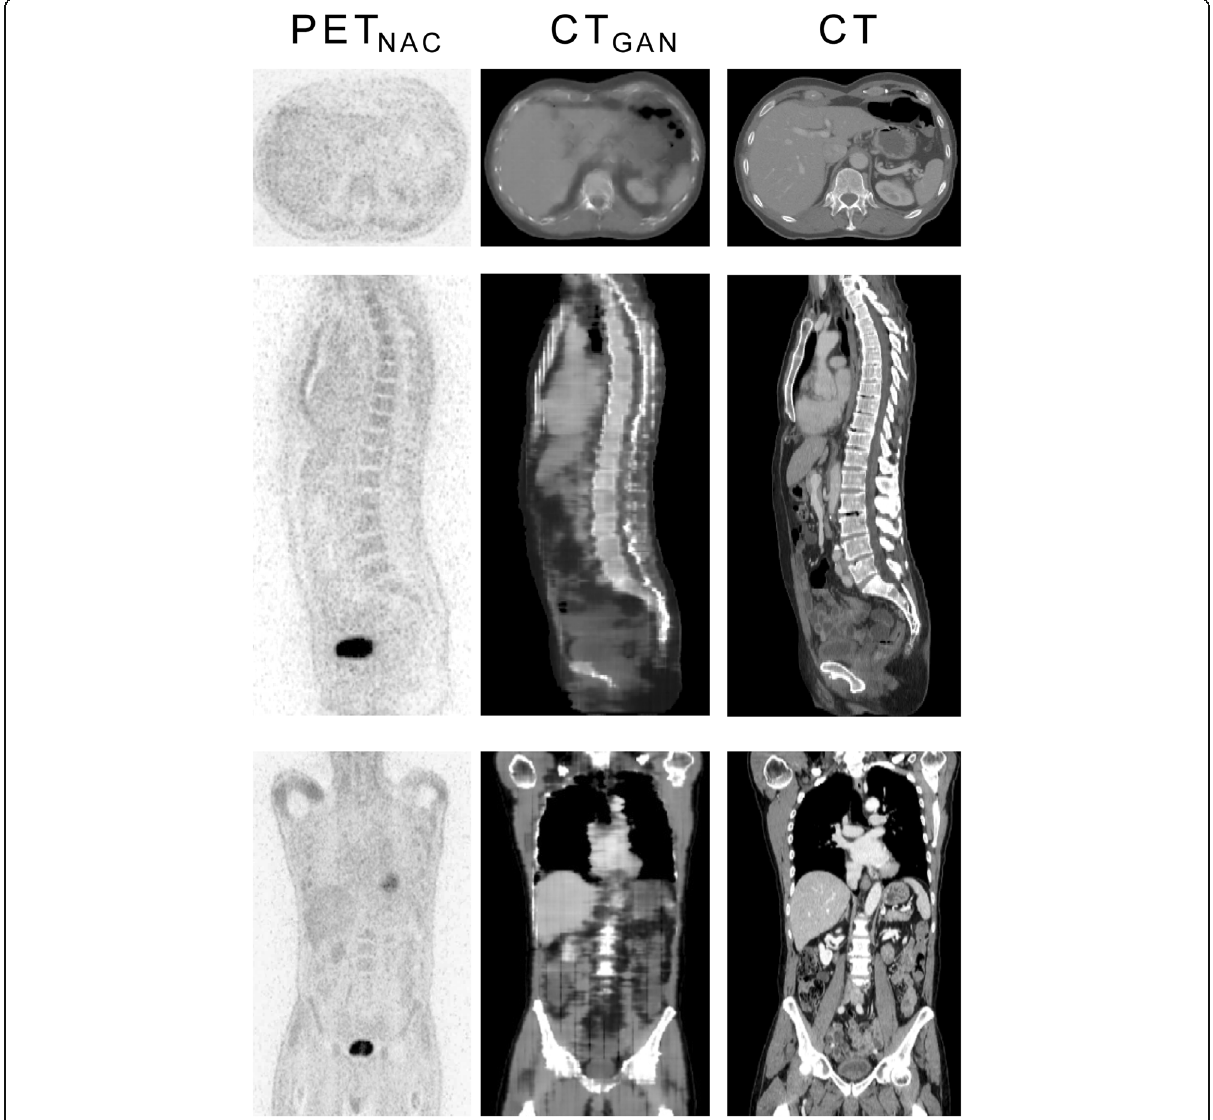
Fig. 2 Representative data set showing non-attenuation-corrected [ 18 F]FDG-PET (left), generated pseudo CT (middle), and acquired CT (right) in axial (top), sagittal (middle), and coronal (bottom) orientation. CT GAN data — while capturing the coarse distribution of CT anatomy — showed blurring and step formation in z -direction on coronal and sagittal reconstruction as well as irregular depiction of anatomical